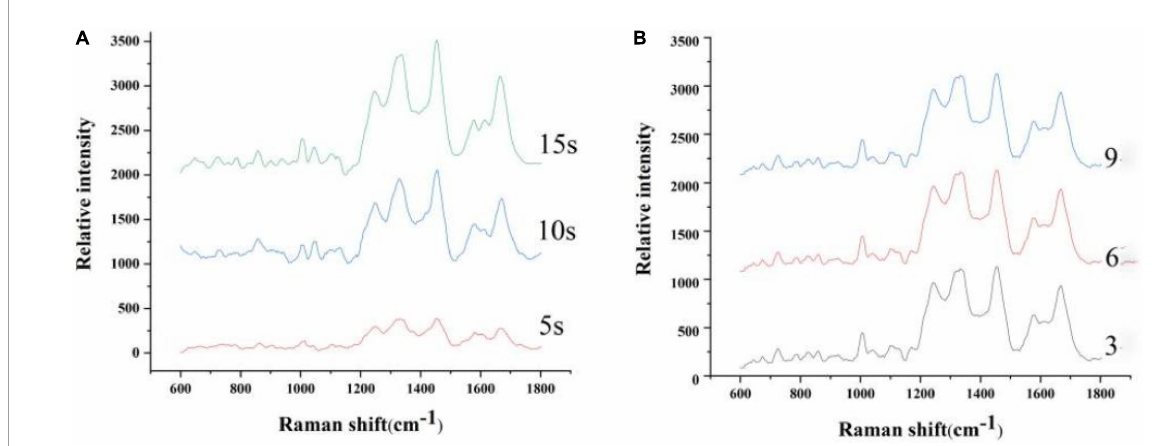
FIGURE1 Spectrum based on the different integration times (A) and number of scan (B) .